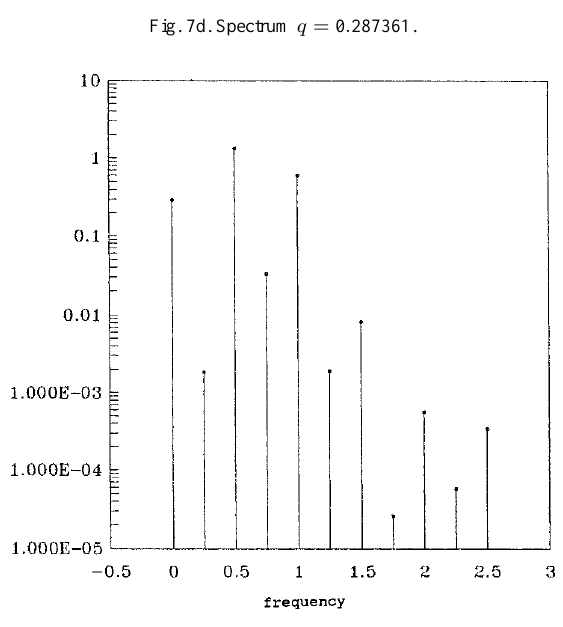
Fig. 7d. Spectrum q = 0 : 287361.